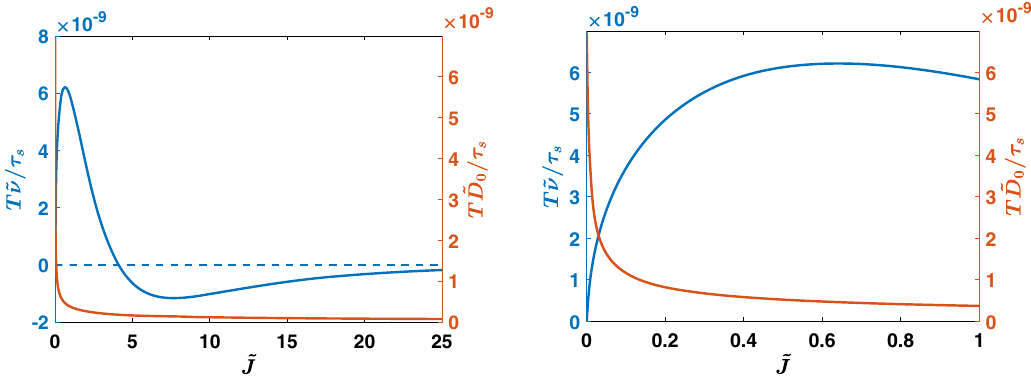
˜ J (data for the eRHIC parameter set). The